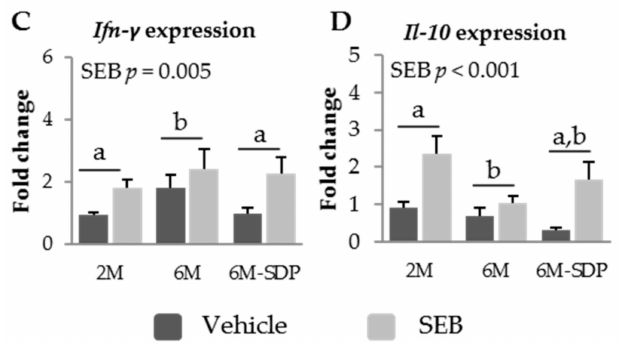
Figure 7. mRNA expression of Il-6 ( A ), Tnf- α ( B ), Ifn- γ ( C ), and Il-10 ( D ) in the jejunum mucosa of SAMP8 mice of the 2-month-old (2M), 6-month-old (6M), and 6-month-old fed spray-dried plasma (6M-SDP). The dark grey bars represent groups that received the vehicle and the light grey bars represent mice administered with S. aureus enterotoxin B (SEB). All the target genes were normalized to glucuronidase β ( Gus β ) expression. The fold change expression is related to 2M mice administered with vehicle. Results are expressed as means ± SEM ( n = 5–6 animals). Means without a common letter differ, p < 0.05. Int., interaction between factors (SEB administration and experimental groups; 2M, 6M, and